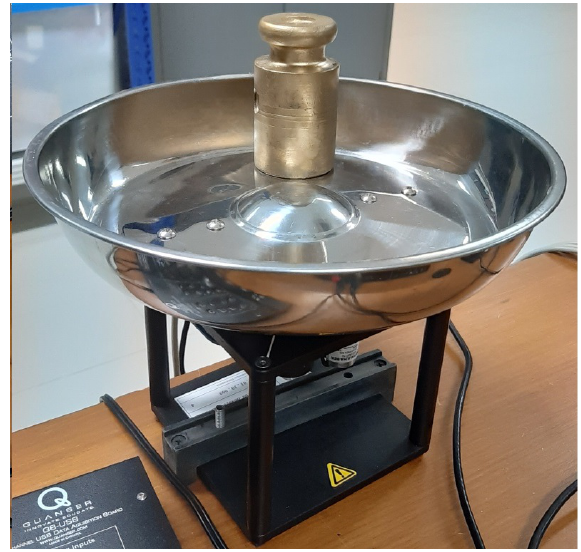
Figure 9. The addition of a load of 1 kg to the experimental tool of the DC motor. The following were the experiments’ outcomes (See Figure 10) when adding a mass load of 1 kg to the plant.